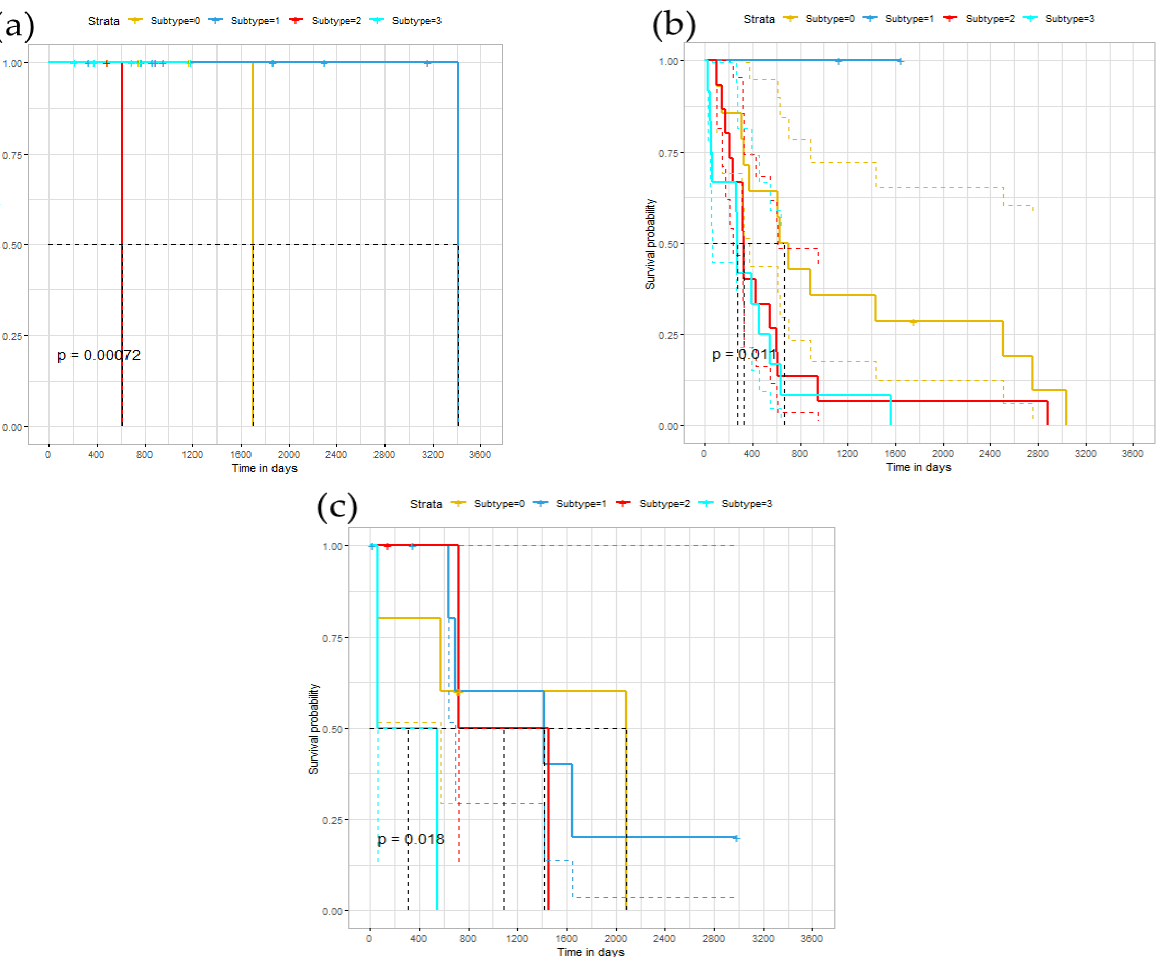
Figure 4. Survival time under different subtypes: ( a ) the survival curve of the BRCA data set; ( b ) the survival curve of the GBM data set; ( c ) the survival curve of the LUNG data set.